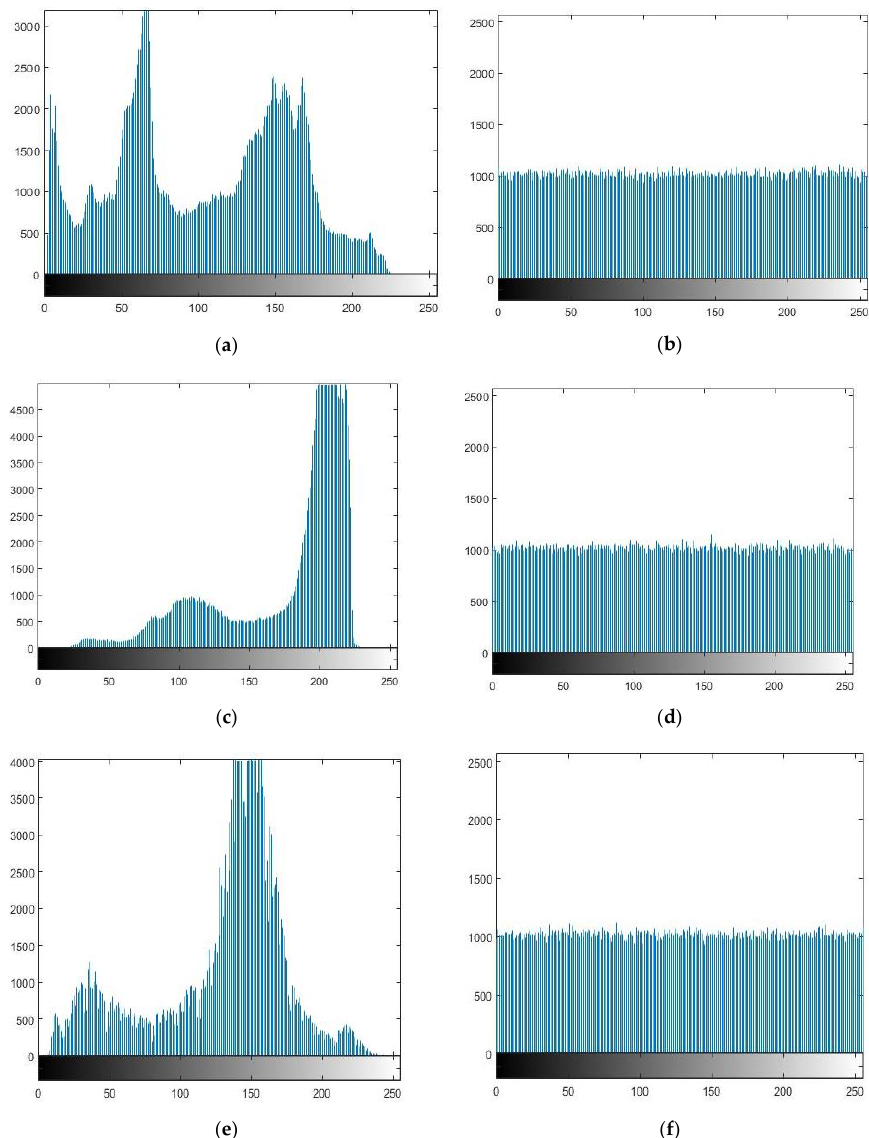
Figure 3. Histograms of original and encrypted images: ( a ) original “Peppers,” ( b ) encrypted “Peppers,” ( c ) original “Airplane,” ( d ) encrypted “Airplane,” ( e ) original “Boat,” and ( f ) encrypted “Boat.”